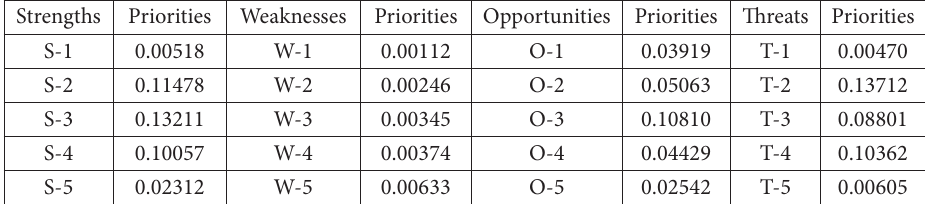
Table 11. The criteria priorities obtained by AHP